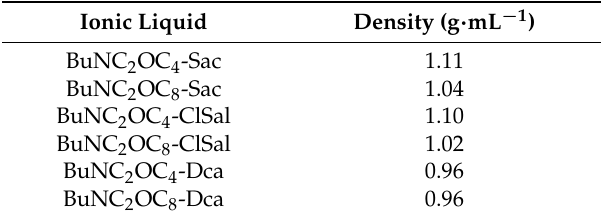
Table 1. Room temperature ionic liquids density at 25 °C.